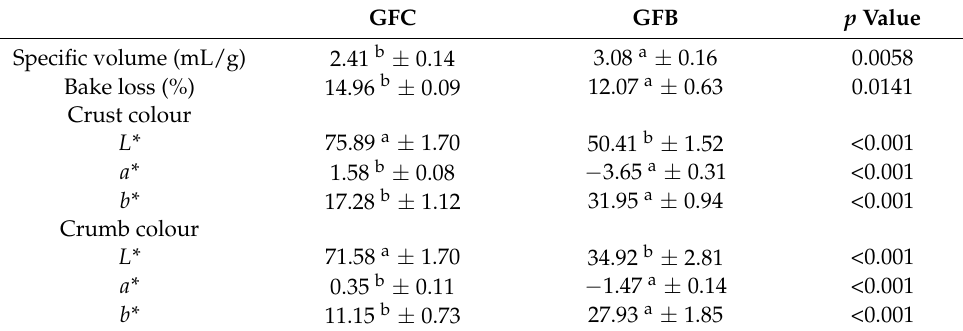
Table 3. Technological parameters of experimental gluten-free bread. GFC GFB p Value Specific volume (mL/g) 2.41 b ±